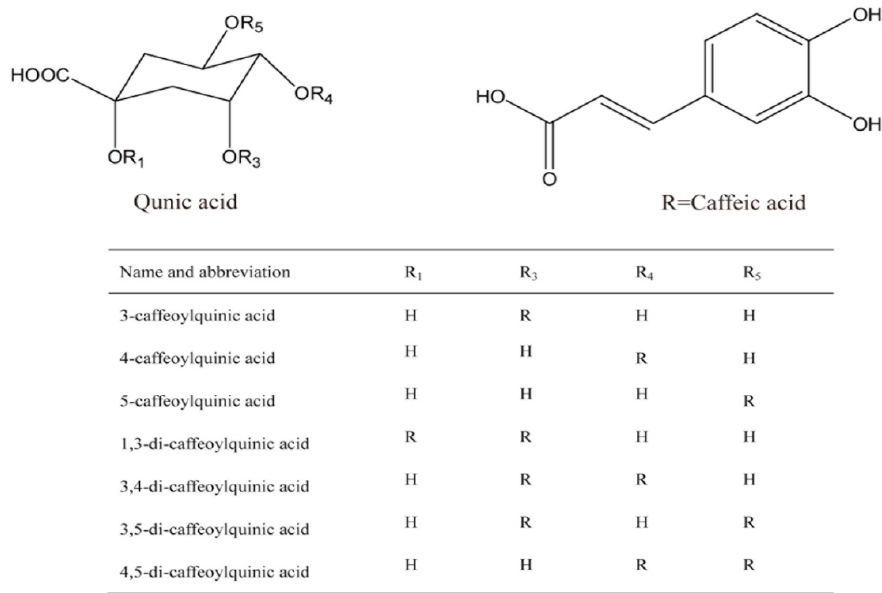
Figure 1. The structures of the seven mono- and di-acyl CQA standards.